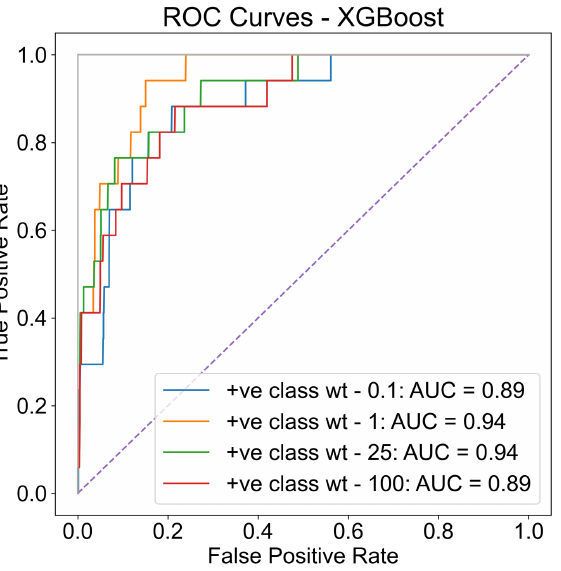
Figure 13. Effect of positive class weights in XG Boost models identifying intermediate and advanced stage attrition.